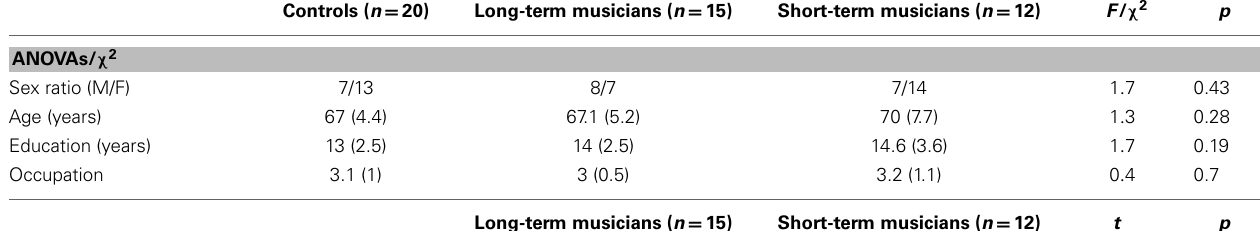
Table 5 | Means ( SD s) and inferential statistics for demographic data and practice characteristics of short-term and long-term musicians (trend/significance p -values: *** p < 0 . 001).